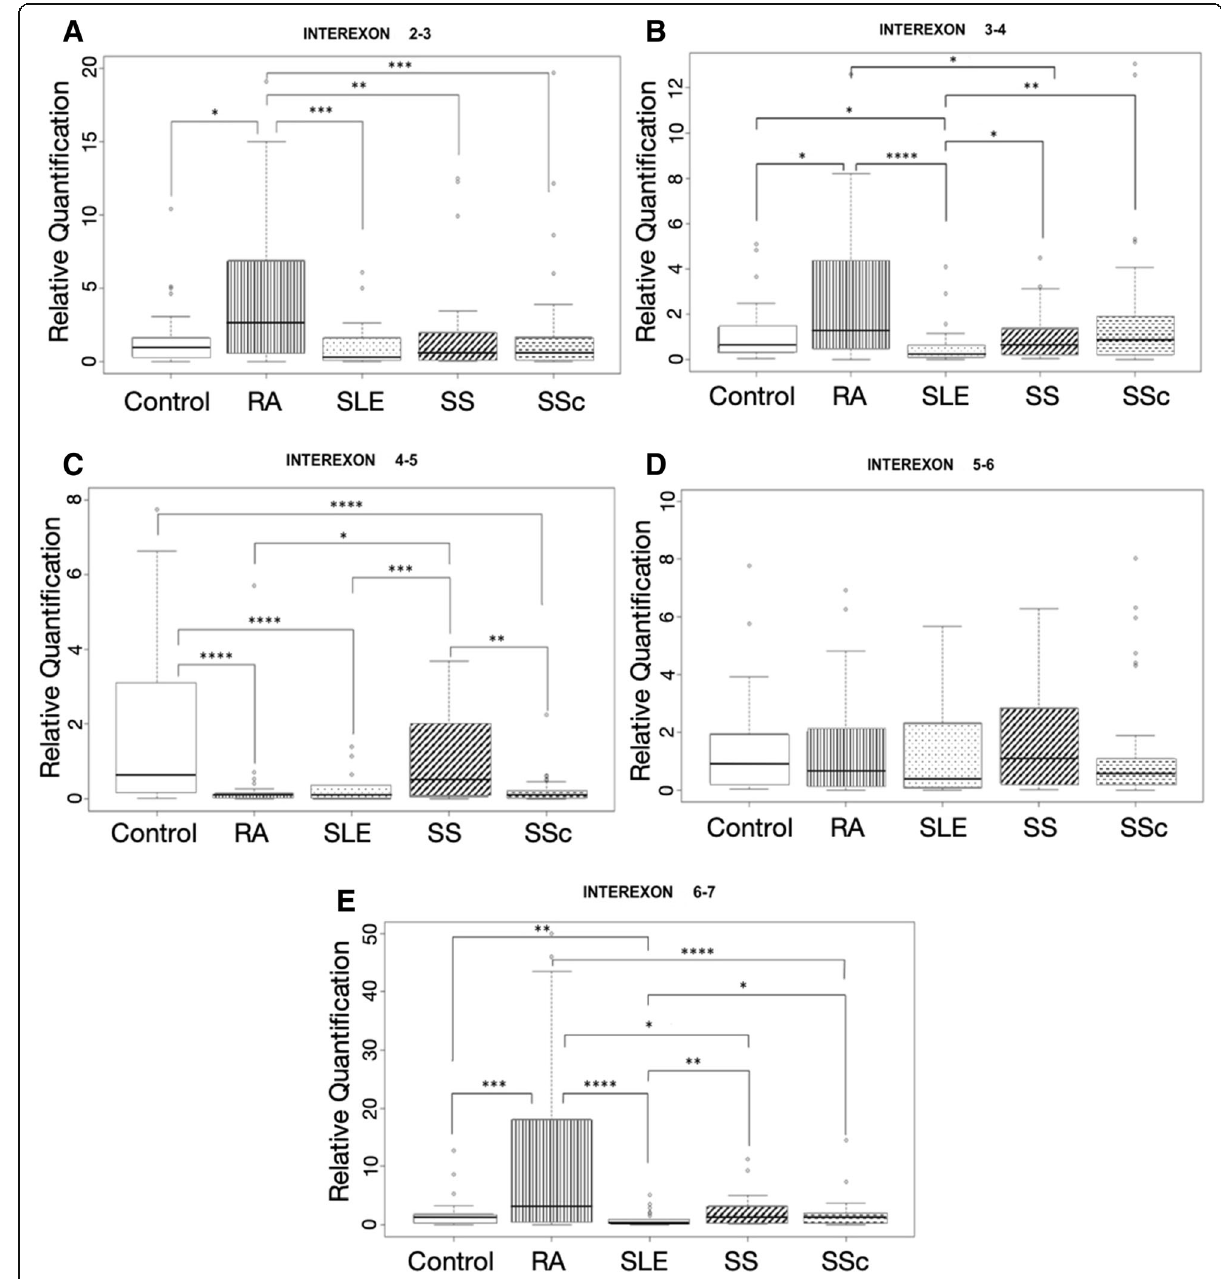
Fig. 2 Expression level of every interexon (IK) in the assessed pathologies: inter-exon 2 – 3 ( a ), inter-exon 3 – 4 ( b ), inter-exon 4 – 5 ( c ), inter-exon 5 – 6 ( d ) and inter-exon 6 – 7 ( e ). RA, rheumatoid arthritis; SSc, systemic sclerosis; SLE, systemic lupus erythaematosus; SS, Sjögren ’ s syndrome. * p ≤ 0.05, ** p ≤ 0.01, *** p ≤ 0.001, **** p <